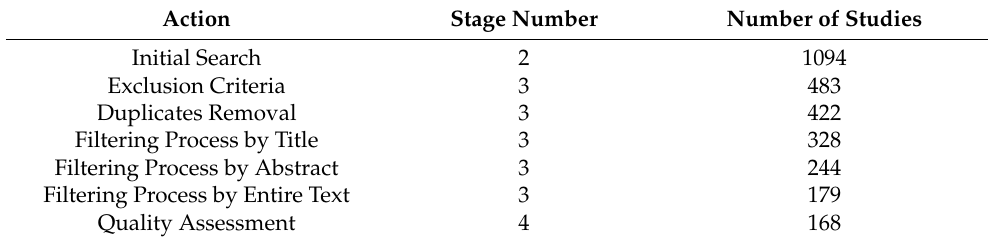
Table 2. Journey of